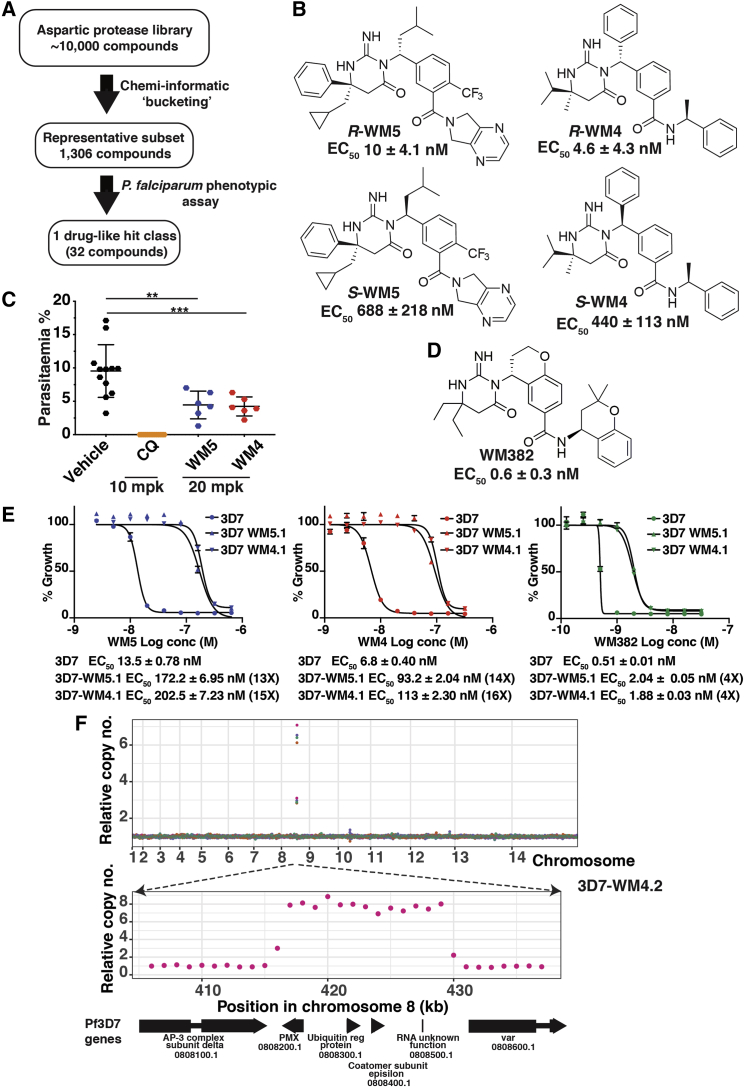
Identification of Compounds that Inhibit P. falciparum(A) Screen using an aspartyl protease compound library to identify inhibitors of P. falciparum growth.(B) Chemical structure of compounds and EC50.(C) WM5 and WM4 suppress P. berghei infection. Two independent experiments; n = 6, mean ± SD. ∗∗p < 0.005, ∗∗∗p < 0.0005.(D) Structure and EC50 of R-WM382.(E) Growth curves for WM5 and 4 resistant P. falciparum. Experiments in triplicate, mean ± SEM.(F) Genome of P. falciparum WM5 and four resistant lines. Top: copy number (10 kb bins) of 3D7-WM4.2 compared to 3D7 for chromosomes, four replicates in four colors. Bottom: 30 kb region (1 kb bins). Gene numbers found at PlasmoDB: https://plasmodb.org/.